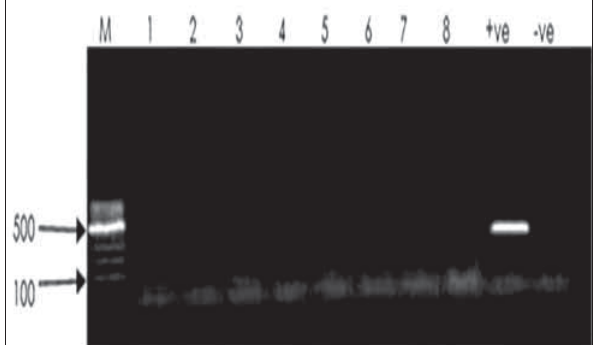
Figure-2: Gel electrophoresis showing African swine fever virus amplification: Lane M, molecular marker of 100 bp. Lane 1-8, formalin fixed tissues DNA from commercial kits.